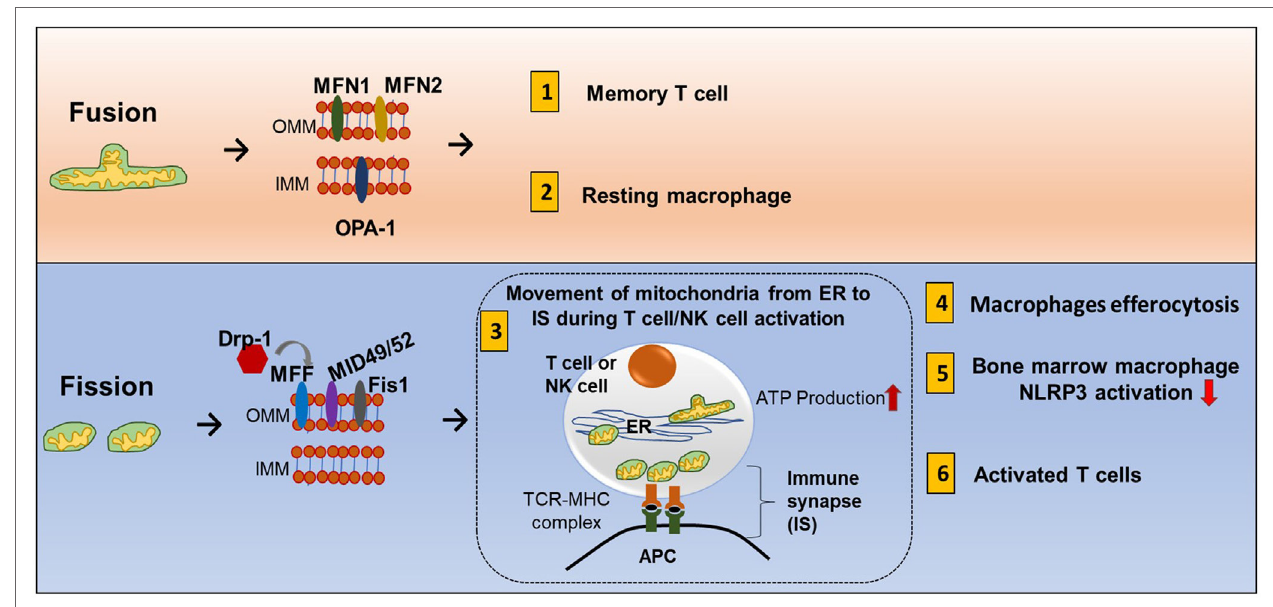
FiguRe 7 | Mitochondrial fission and fusion contribute to immune responses. Mitochondrial fission and fusion controls mitochondrial mass. Nutrient deprivation induces an increase in mitochondrial fusion and suppression of mitophagy. On the other hand, prolonged DNA damage leads to mitochondrial fission. Fusion (tubular mitochondria) is controlled by two dynamin-like GTPases for the outer membrane proteins (mitofusin MFN1 and MFN2) and inner membrane proteins (OPA1). Fission (fragmented mitochondria) is coordinated by four outer membrane proteins (Drp1, Mff, Mid49, and mid52). Fusion and fission of mitochondria contribute to immune response. (1) Memory T cells have increased fusion generating more oxidative phosphorylation (OXPHOS) and FAO. (2) Clearance of apoptotic cells by phagocytes is known as efferocytosis. Resting macrophages have displayed tubular mitochondria. (3) Fission contributes to mitochondria mobility. During antigen-specific T cell and NK cell activation, mitochondria fission increased, and mitochondria move toward the immune synapse (IS) and facilitate ATP production at the IS. (4) Uptake of apoptotic cells by macrophages during efferocytosis requires fission and increased Drp1. (5) In mouse-derived bone marrow macrophages, knocking down Drp1 initiates NLRP3 inflammasomal activation, and inducing mitochondrial fission attenuated NLRP3 inflammasomal assembly and activation. (6) Activated effector T cells have increased mitochondrial fission and exhibit higher rates of